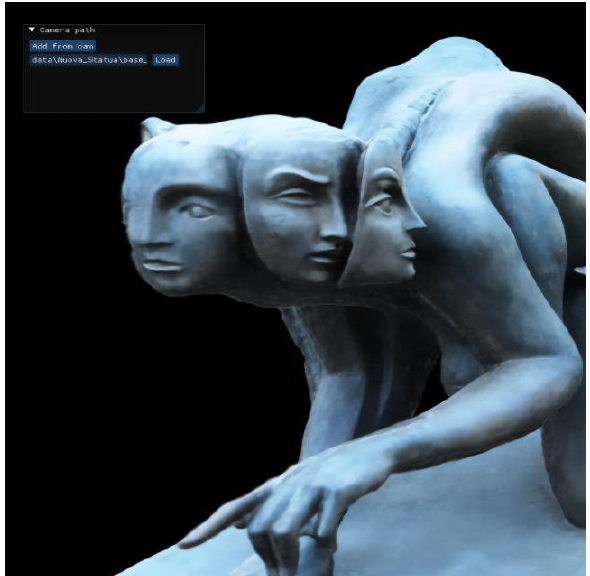
Figure 6 . Figure placement and numbering